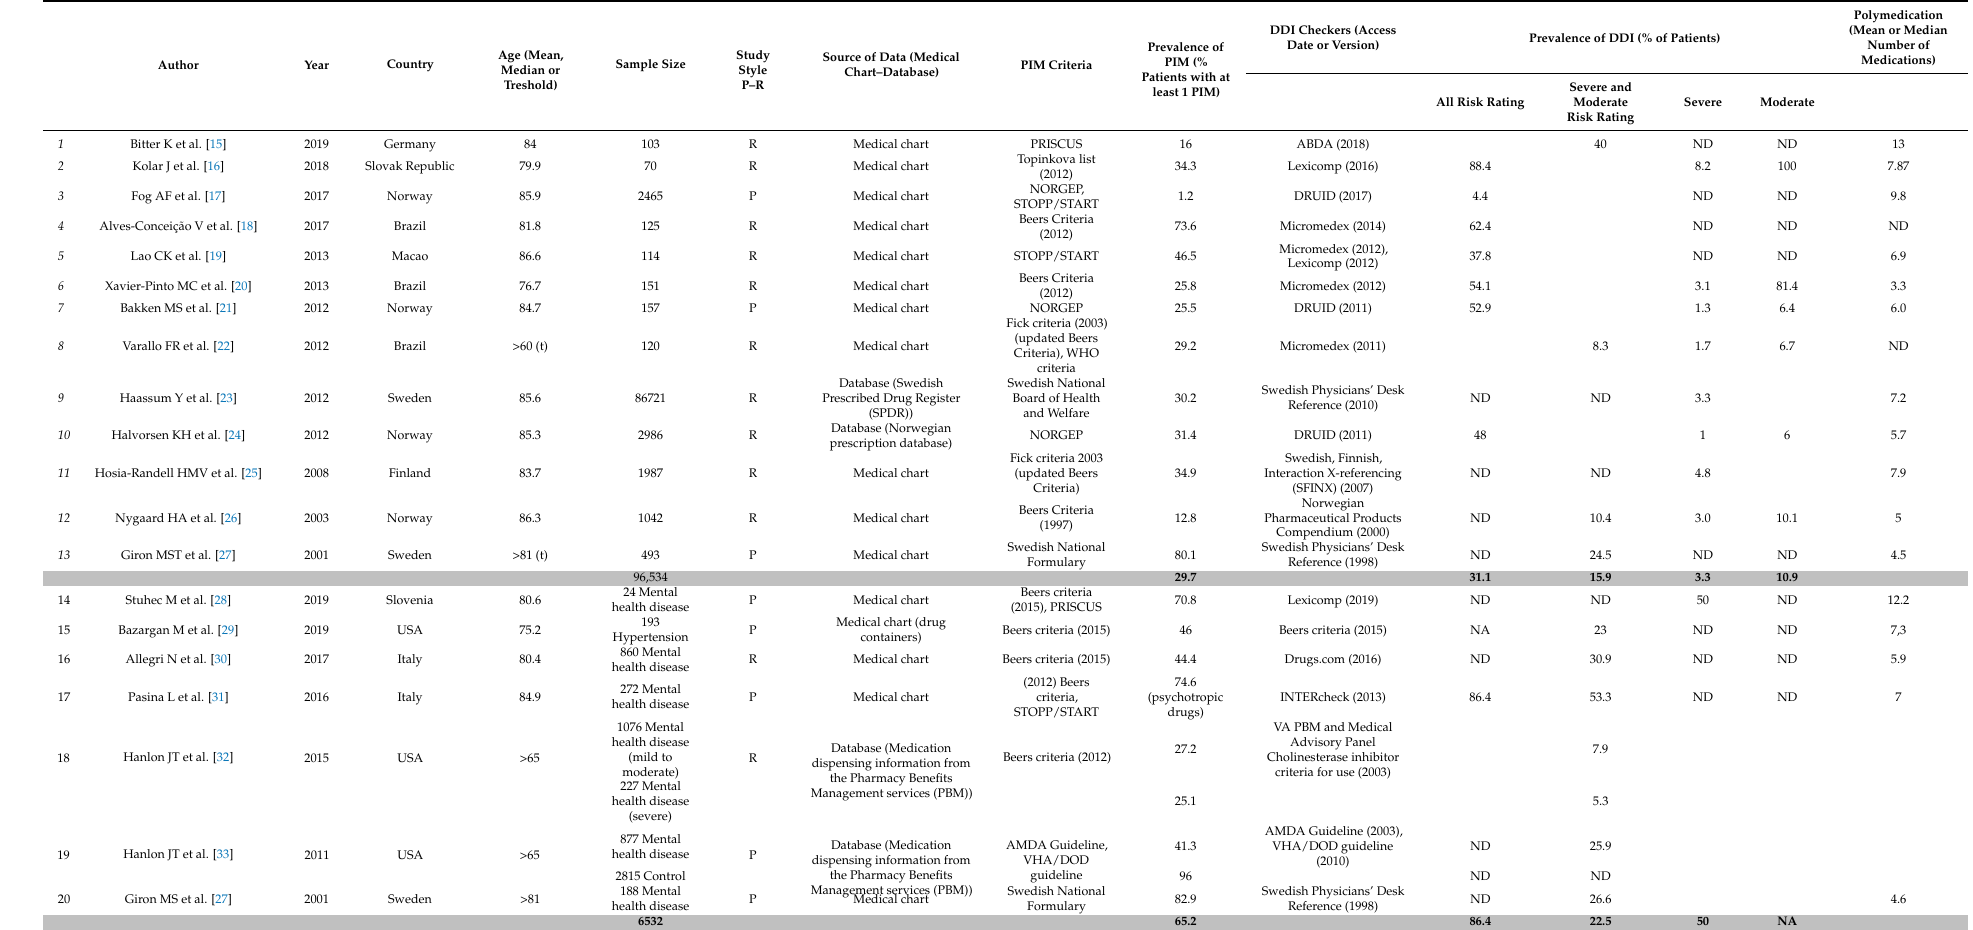
Table 1. Prevalence (%) of potentially inappropriate medications (PIM) and drug–drug interactions (DDI) (total, severe and moderate) and polymedication (mean or median) in elderly patients in nursing home setting. At the end of the table, the prevalence of PIM and DDI is reported as the weighted mean (in bold). Footnote: Prospective (P), retrospective (R), mean (M), median (m), threshold (t), severe (S), moderate (M), not apply (NA), not determined